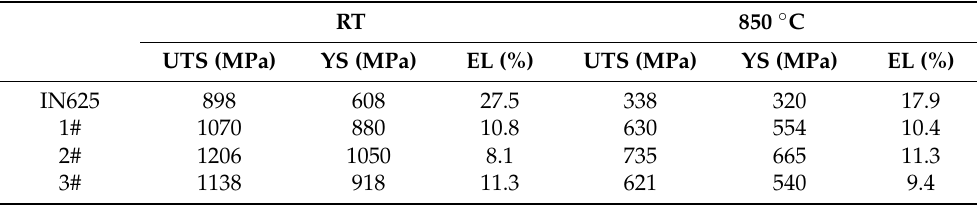
Table 2. Tensile properties of the different coatings under varying conditions.